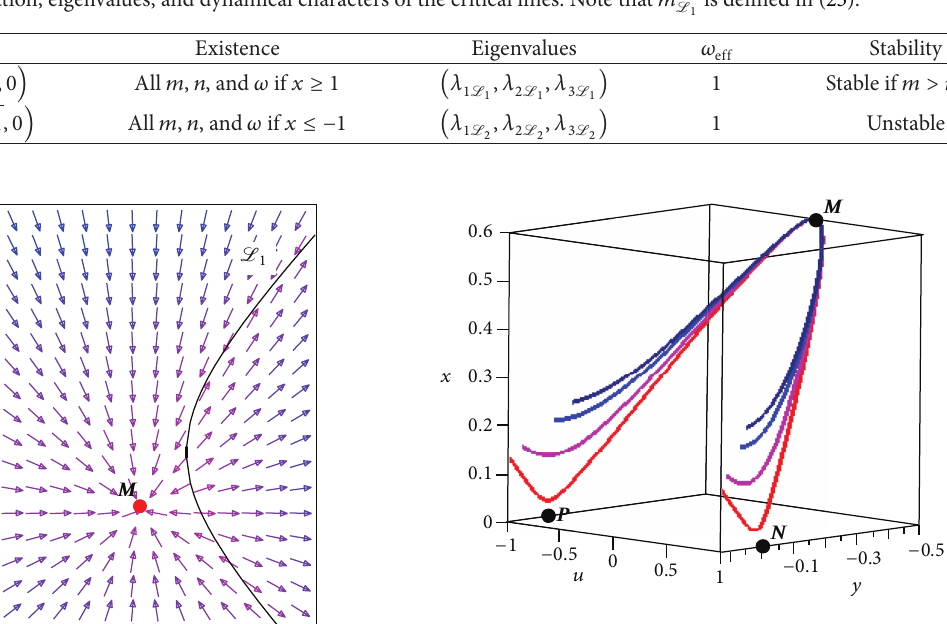
Figure 4: 3-dimensional phase space trajectories of the model with 𝑚 = 0.6 , 𝑛 = 0.5 , 𝛽 = 1 , and 𝜔 = 0 . For these values of parameters, we have a potential energy dominated solution (point M ) which is a stable attractor. The points N and P (corresponding to the effectively matter dominated era) are saddle